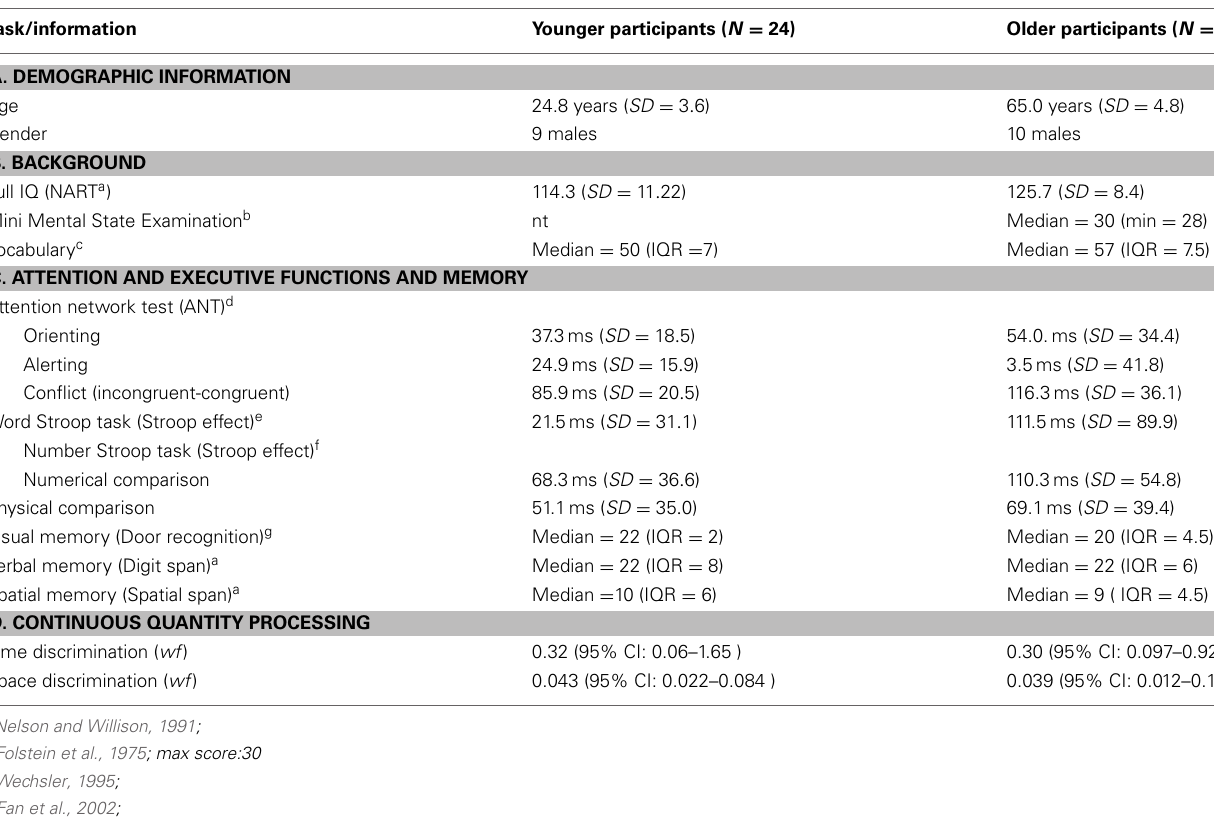
Table 1 | Demographic data and descriptive statistics for the younger adult (left) and older adult (right) groups in Study 1.